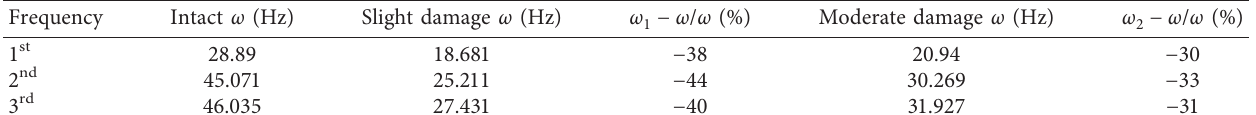
Figure 1: Shapes of the first three modes of the intact polymer cutoff wall. (a) First vibration mode. (b) Second vibration mode. (c) Third vibration mode. Table 2: First three natural frequencies of the horizontally damaged polymer cutoff wall.